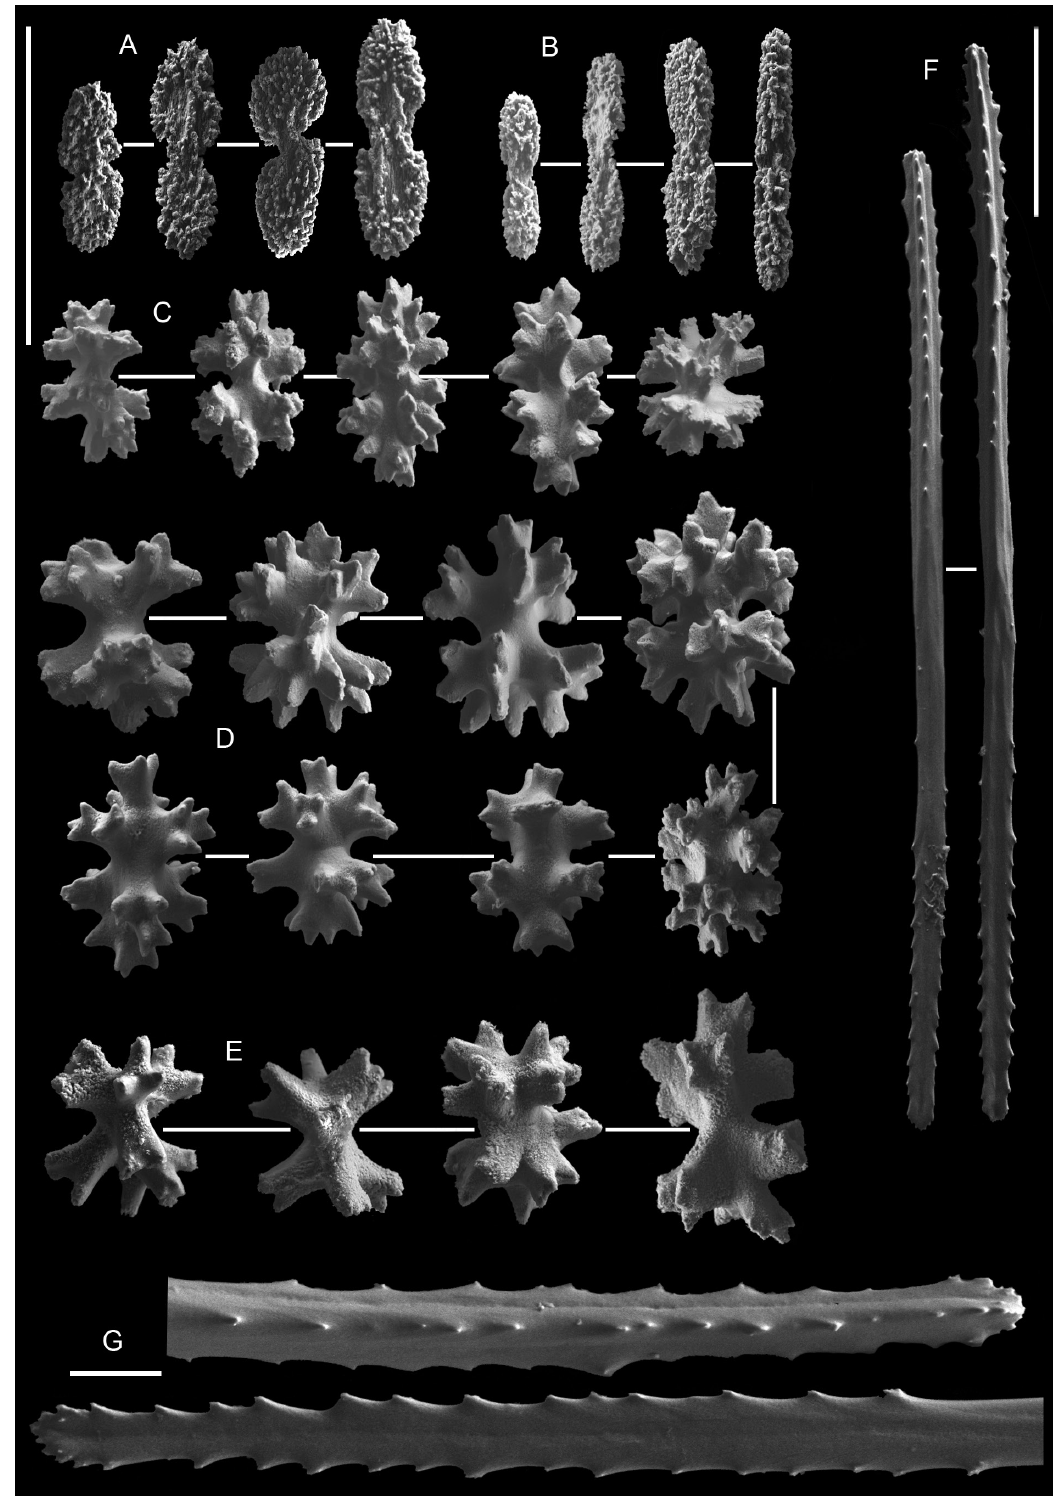
Fig. 8. Heteropolypus roseus sp. nov., holotype (MIMB 42495); sclerites from the autozooid pharynx, anthocodiae, and the colony body. A . Waisted plates. B . Rods. C . Anthocodiae capstans. D . Capitulum surface capstans. E . Stalk surface capstans. F . Needles. G . Ends of the same needle. Scale bars: A–F = 0.1 mm; G = 0.02